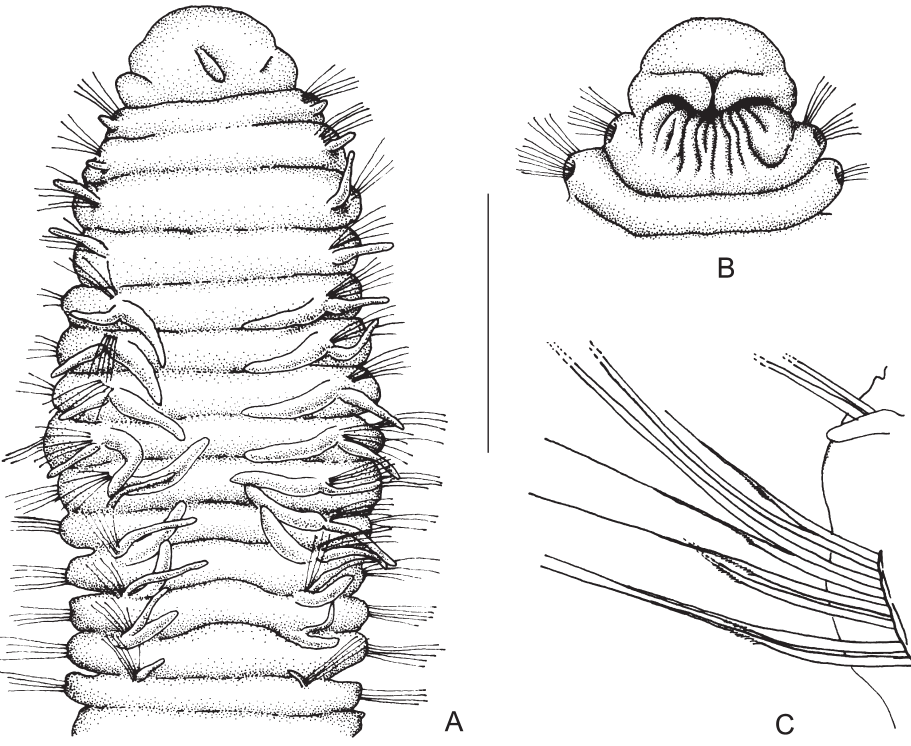
Fig . 15. – Aricidea ( Allia ) sardai n. sp. Holotype (Mncn 16.01/11206): A, anterior region, dorsal view; b, anterior region, ventral view; c, parapodium, chaetiger 67. Scale bar: A 415 µ m; b 410 µ m; c 95 µ